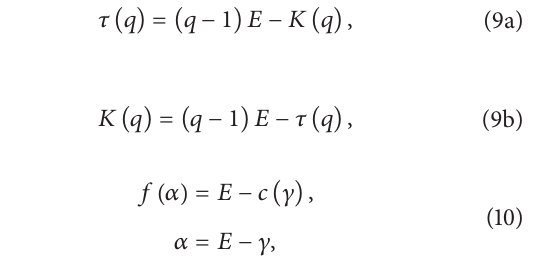
a change in the altitude threshold would affect the fractal dimension ( 𝐷 0 ). The intuitive notion of the 𝐷 0 of a set of points is that the number of disjoint boxes of size 𝛿 (𝑁(𝛿)) needed to completely cover the set varies according to